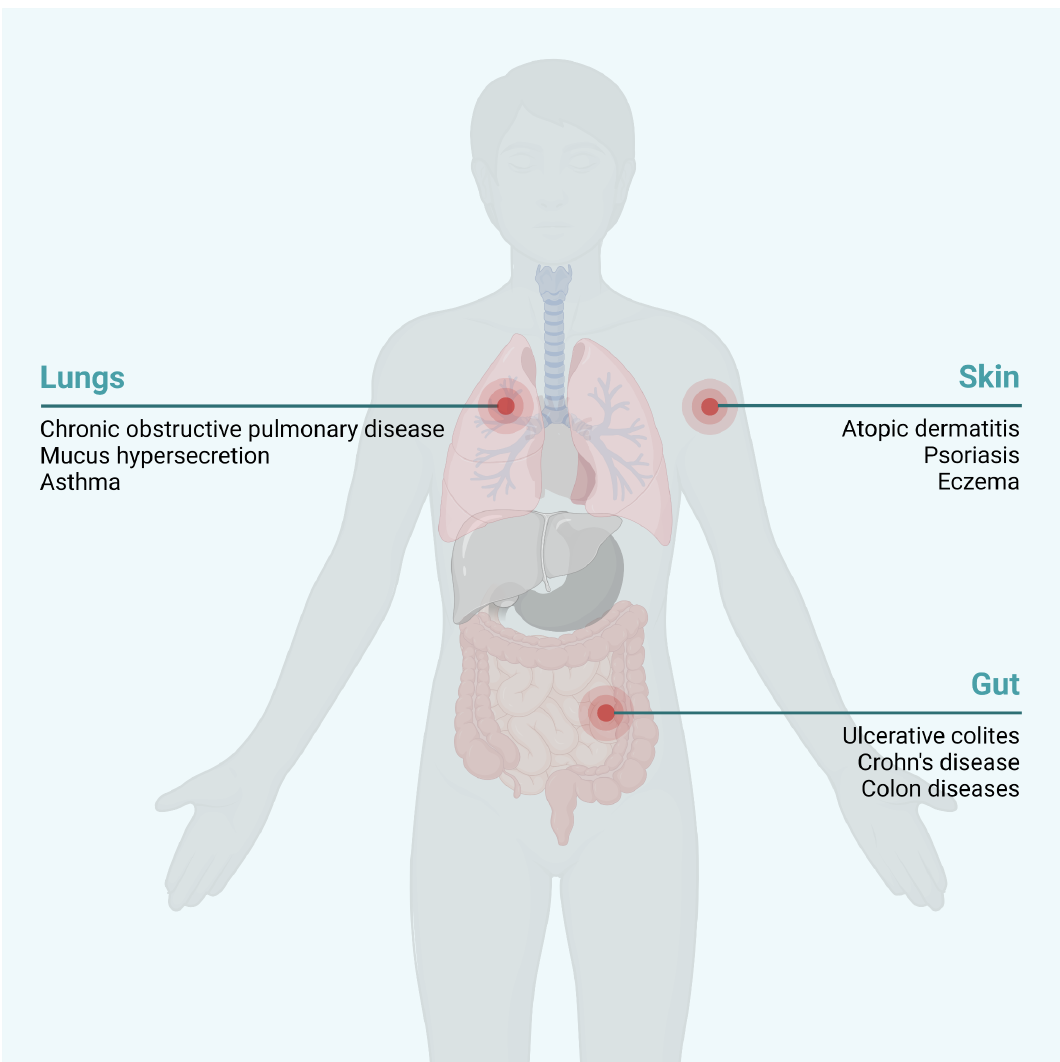
Figure 3. Chronic inflammatory diseases potentially developed by pesticide exposure. Pesticide ex- posure has been linked to the development of several immune-mediated inflammatory diseases (IMIDs), mainly in the skin, airway system, and gut. Created with BioRender.com.